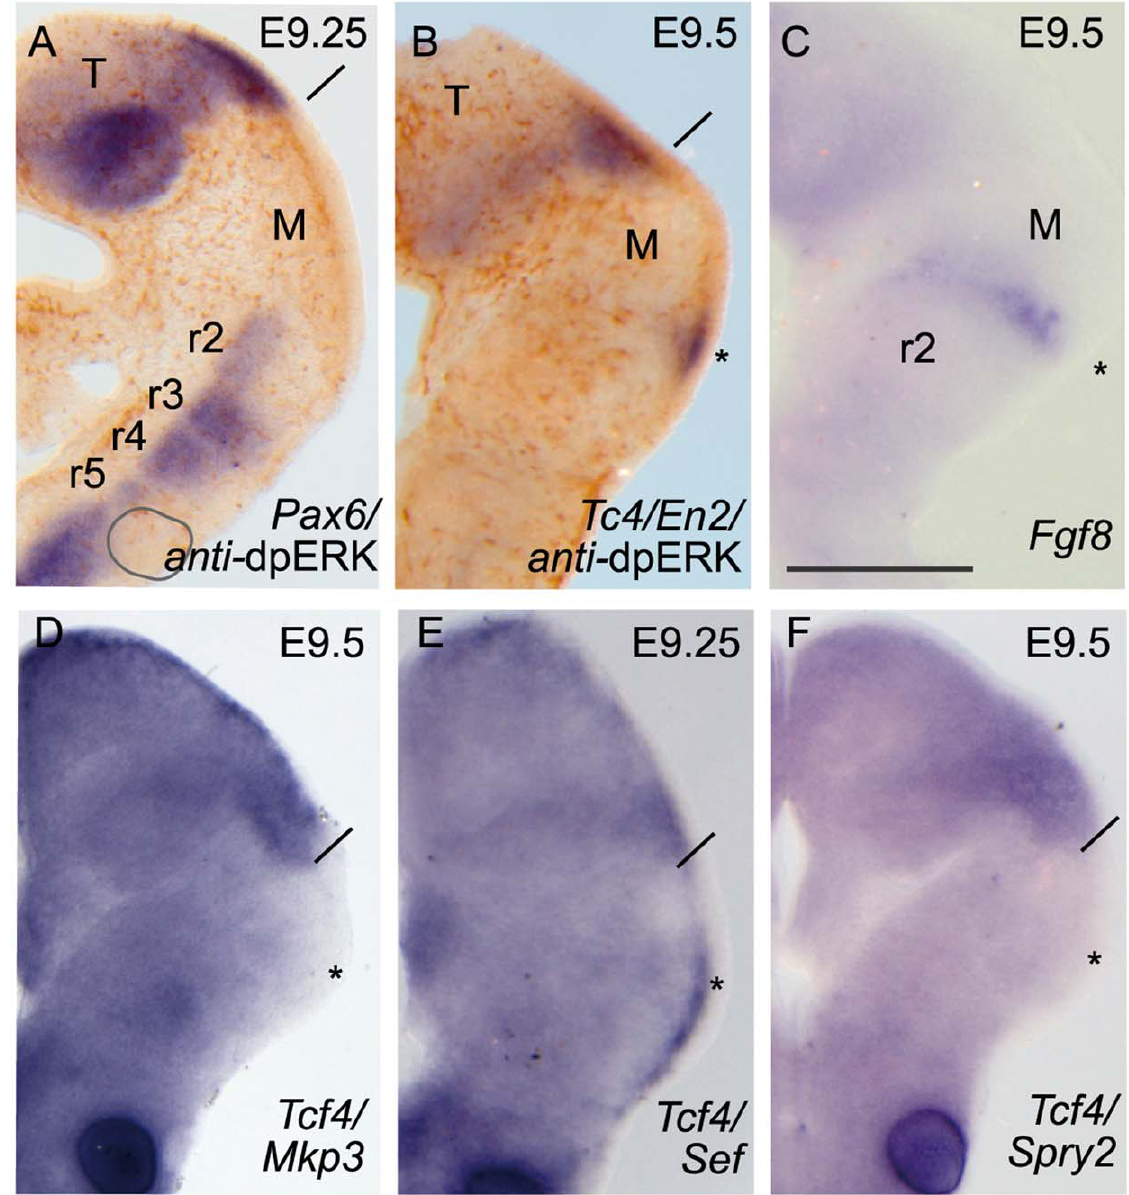
Figure 2 . Low threshold of FGF8 protein levels disrupts ERK1/2 phosphorylation patterns. DpERK immunodetection was absent in the isthmic domain using ONTCs severe hypomorphic mouse mutant (A, B; Fgf8 neo/null [45]). Yet a small tip of En2 (B) positive expression was visible at the most dorsal parts, probably by the maintenance of Fgf8 (C) expression. Under these mutant conditions, none of the FGF8 signal negative modulators Mkp3 (D), Sef (E) Sprouty2 (F) were observed at IsO. Asterisks indicate the position of abolished isthmic region and solid line the boundary between diencephalon/mesencephalon. Scale bar in C is 0,5 mm for all images.